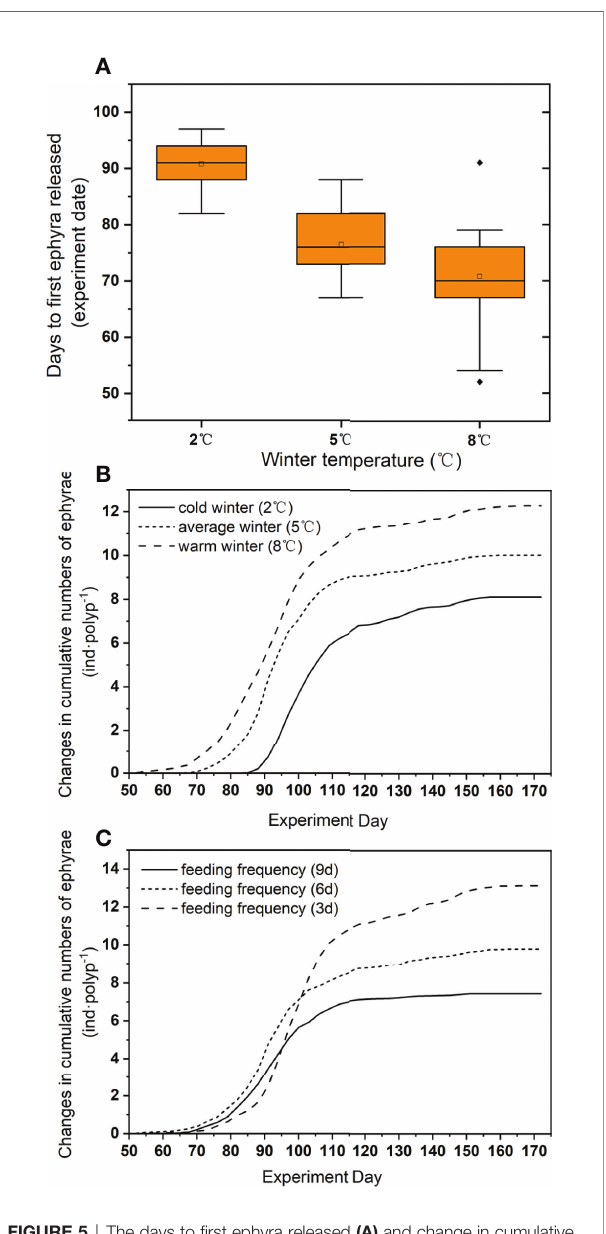
FIGURE 5 | The days to fi rst ephyra released (A) and change in cumulative number of ephyrae at 3 winter temperatures (B) and 3 feeding frequencies (C) . The solid line in each box represents the median and the hollow circle represents the mean. The extremities of the box denote the fi rst and the third quartiles and the ends of vertical lines denote the range. Any points beyond the ends of vertical line are